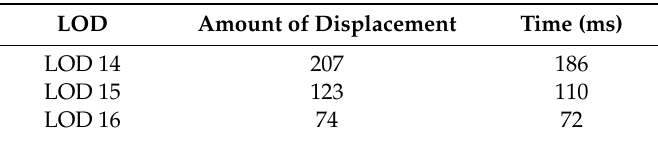
Table 4. Execution time at three LODs.